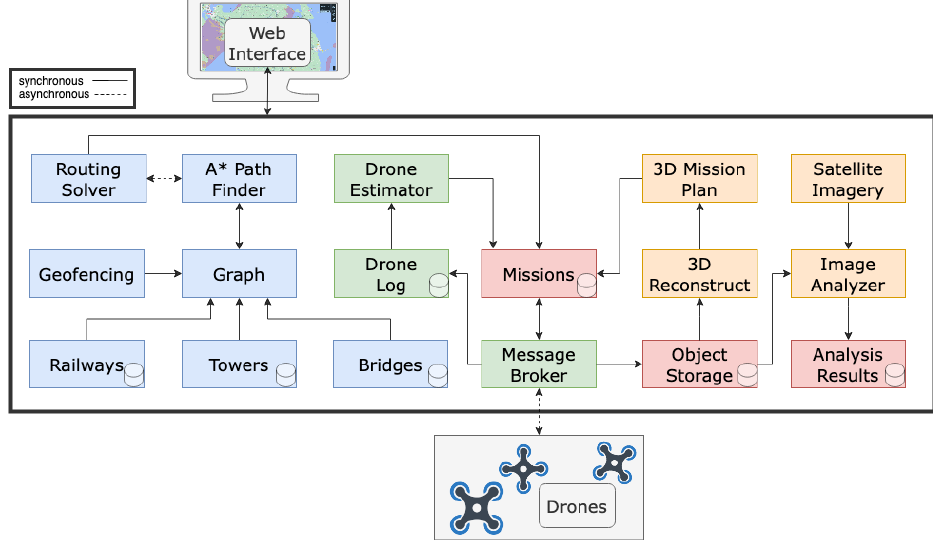
Figure 5. Microservice application architecture showing planning (blue), monitoring (green), storage (red), and analysis (orange)